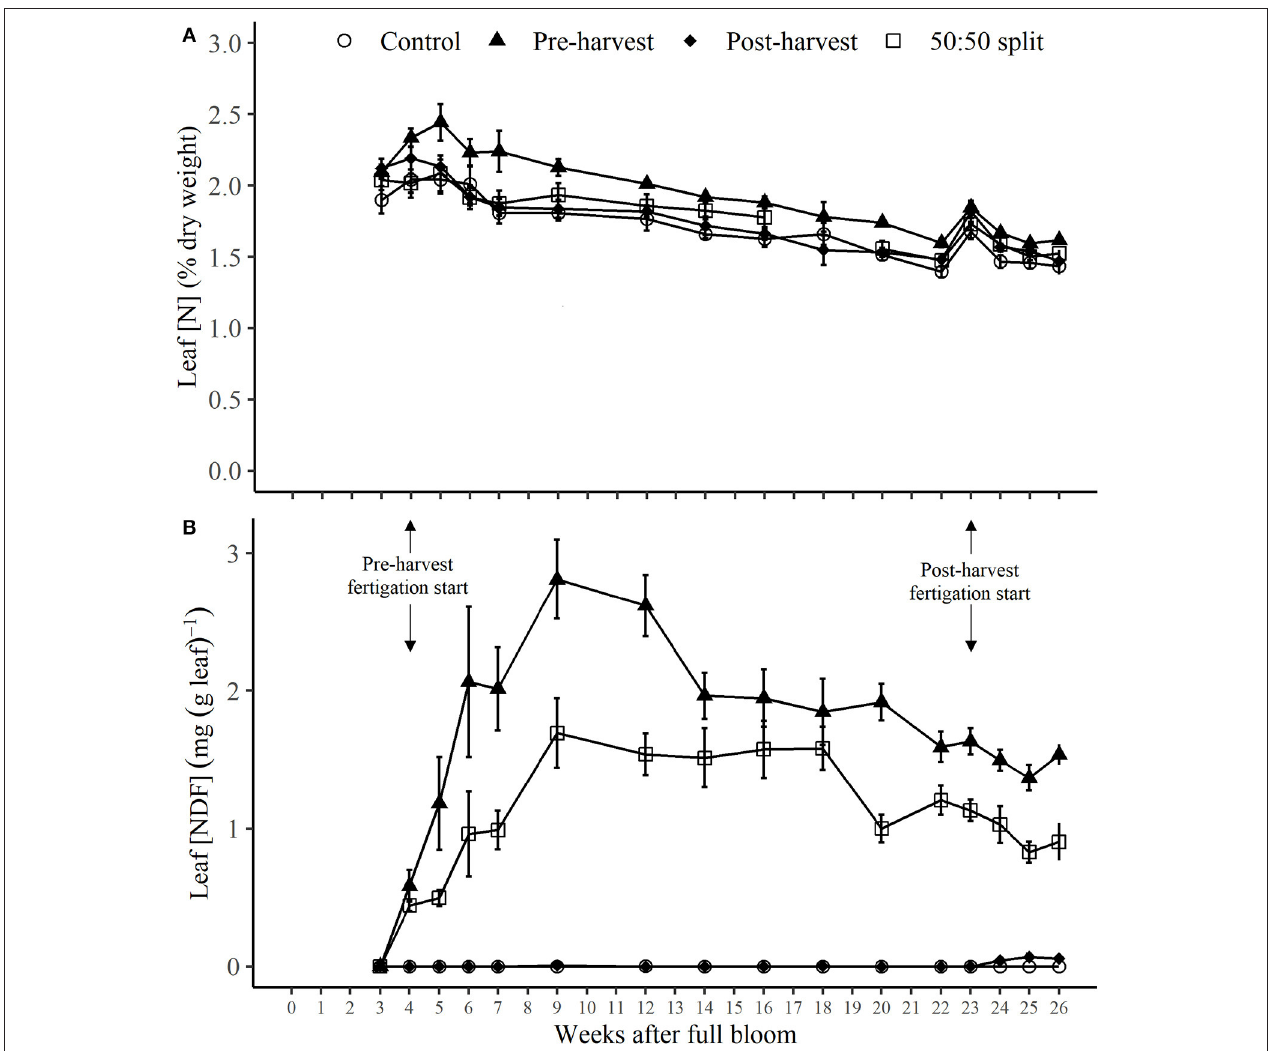
FIGURE 4 | Dynamics of leaf N concentration [N] (A) and concentration of nitrogen derived from fertilizer (NDF) [NDF] (B) for N-treated trees during the 2017–2018 season following different N application timings. Error bars represent ± SEM, n = 4. Fruit was harvested at 22 WAFB.